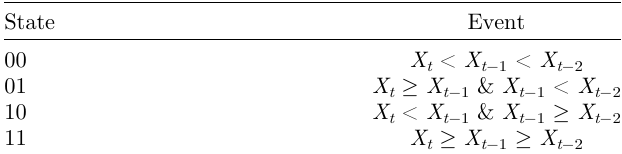
Table 10. States s 2 S and consumption behavior, codi fi cation Y i,t – see equation